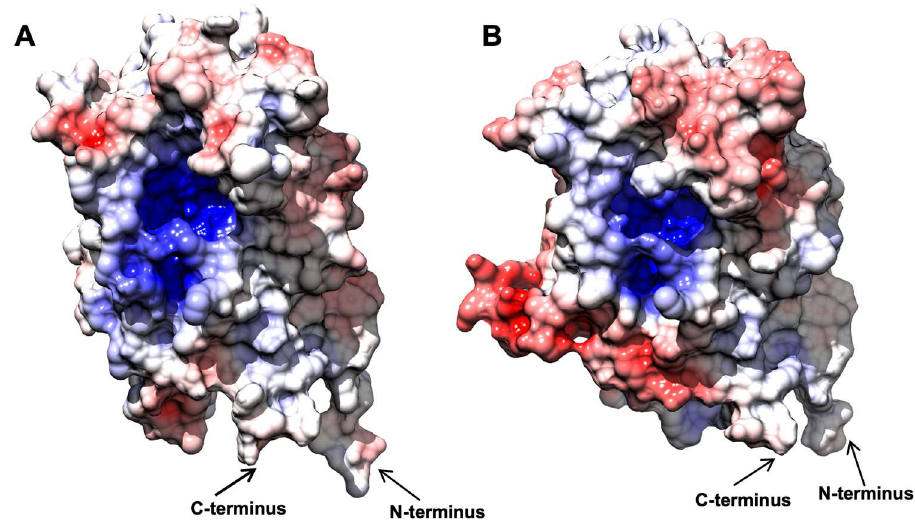
Figure 4. Comparative analysis of surface charge distribution, calculated at 150 mM NaCl, pH 8.0, and 310 K. An OYE8 is on the left ( A ), and Bf OYE4 is on the right ( B ). Density of negative potential is red, positive is blue, and neutral is white.